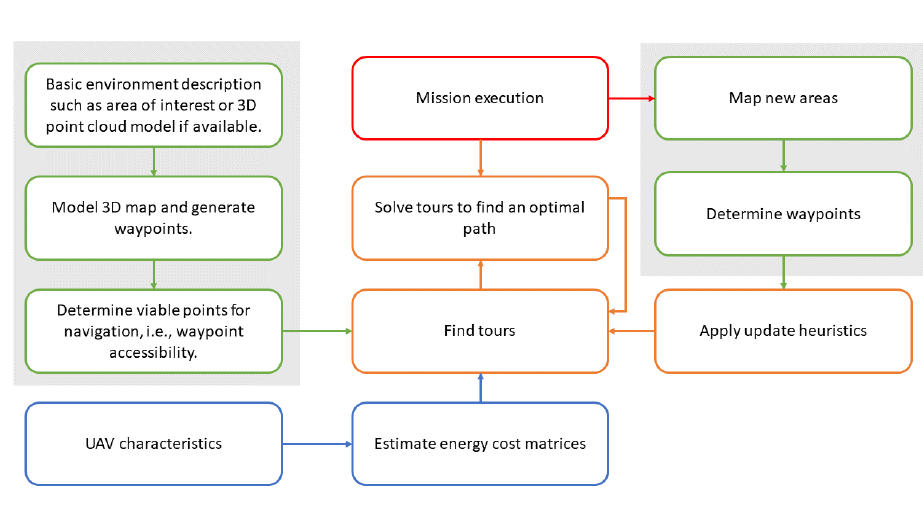
Figure 1. Overview of the proposed